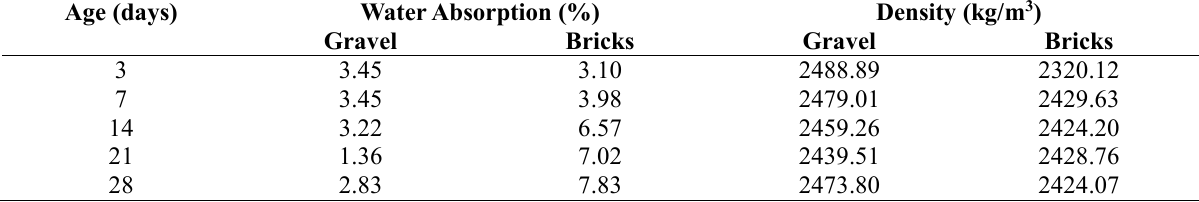
Water Absorption properties and Densities of concrete